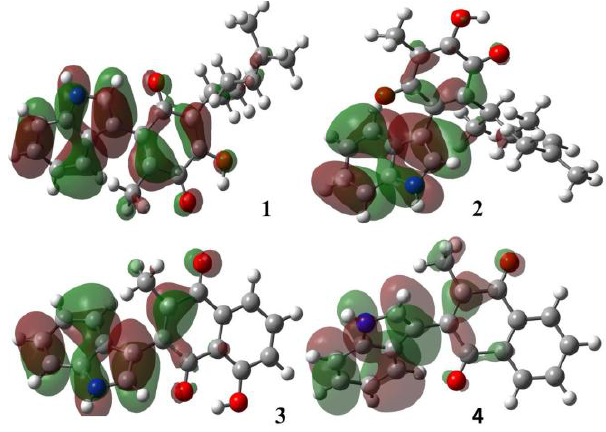
Figure 4. Molecular HOMO orbitals of the target molecules.